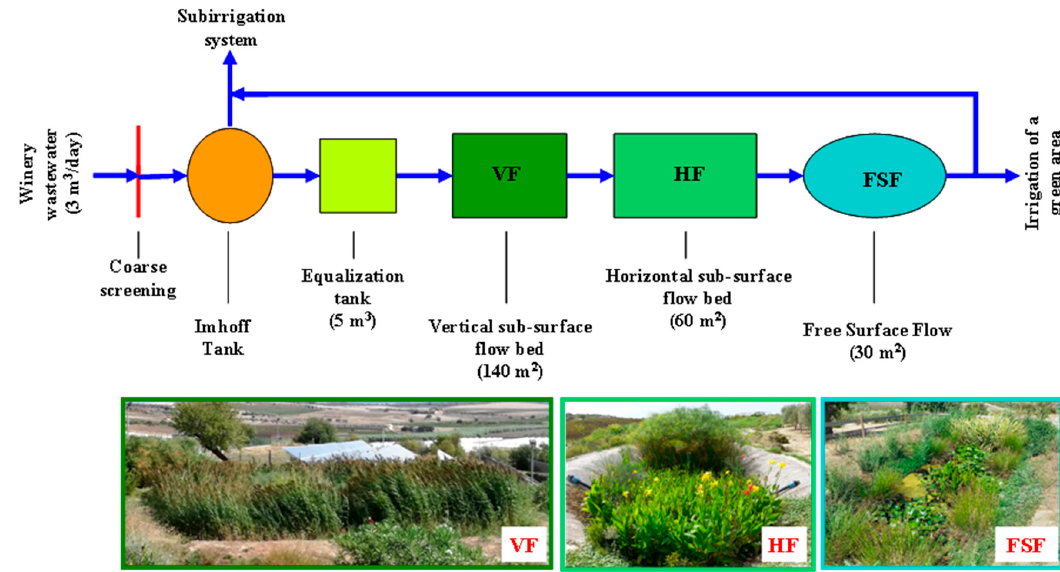
Figure 1. Layout of the multistage pilot constructed wetland (CW) located at the Marabino winery (Sicily, Italy).